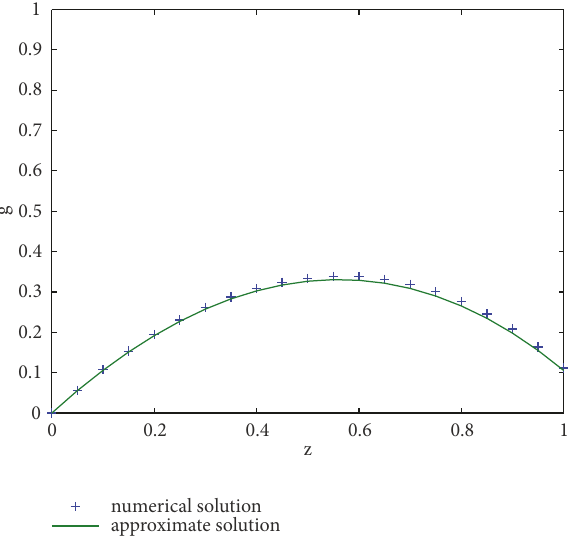
Figure 5: Flux distribution for 𝛼 = 1.0 , 𝑛 = 1.0 , 𝑘(𝑧) = 𝑧 , ℎ(𝑧) = 1 − 𝑧, (1 − 𝑧) 2 , (1 − 𝑧) 3 .